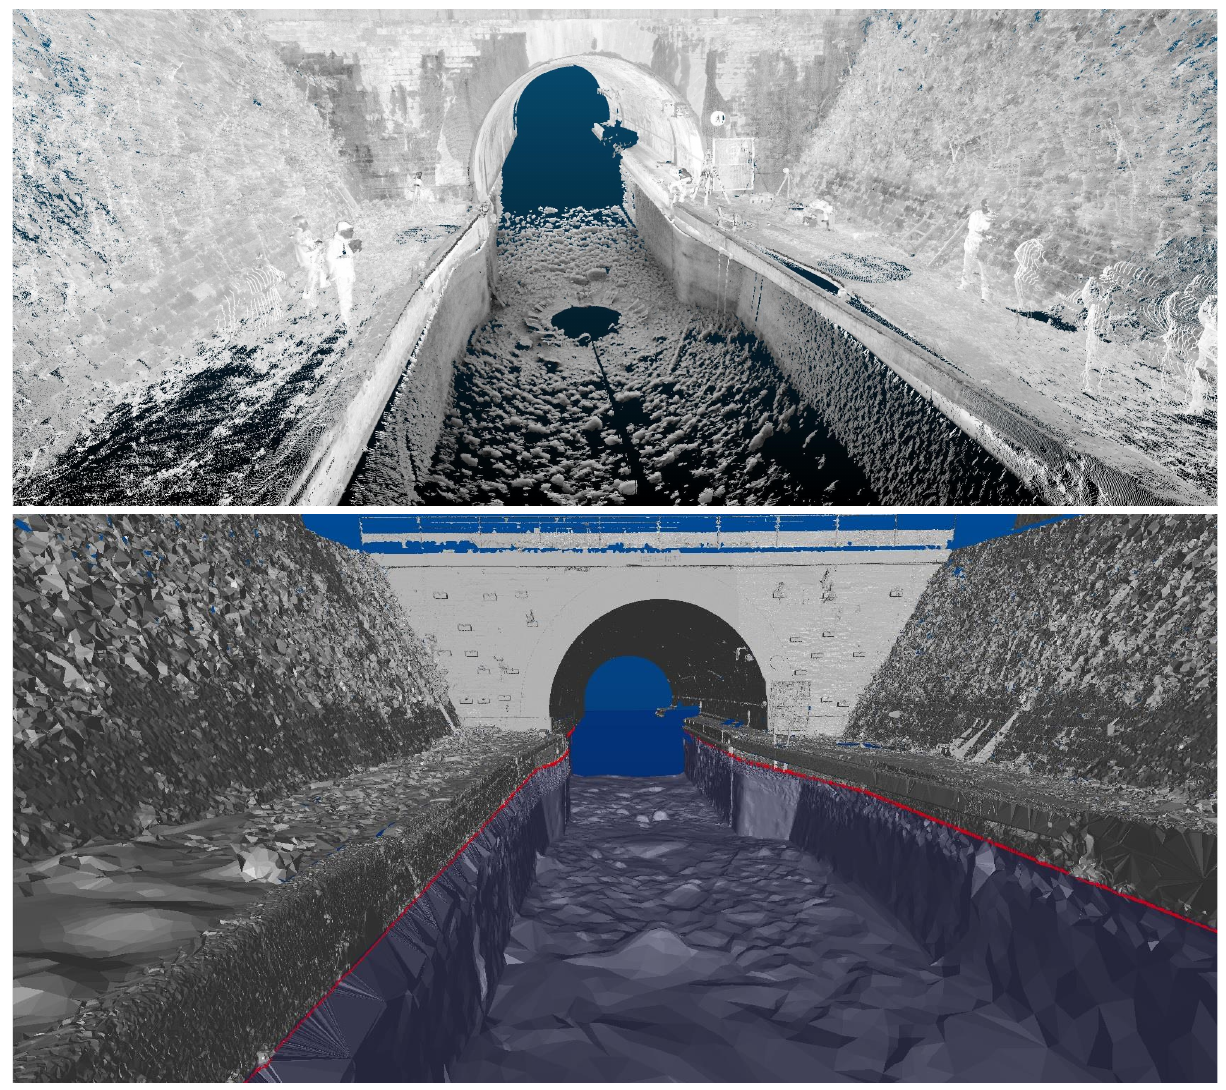
Figure 8: Resulting full 3D geo-referenced model of Niderviller’s canal tunnel entrance. Top: point cloud visualization; bottom: mesh visualisation (the blue mesh is the underwater model and the red line defines the